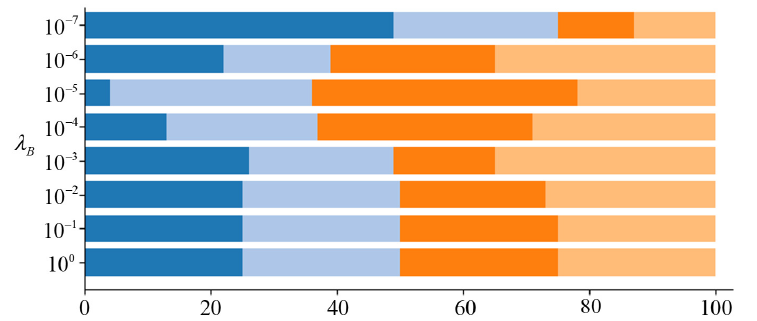
Figure 3. Effect of group balance regularization. The bar graph shows group assignment results for different values of λ B with K = 4.